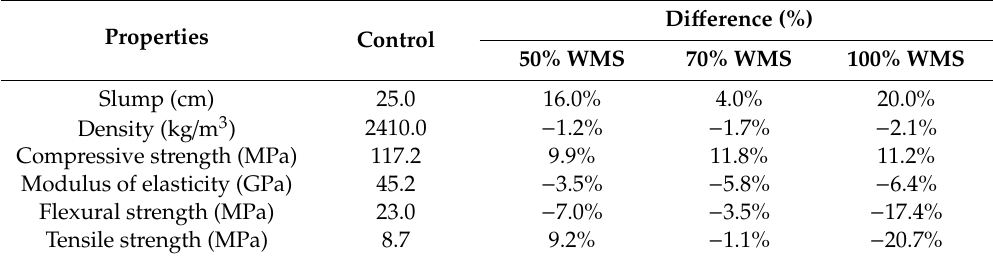
Table 4. Results of the experimental